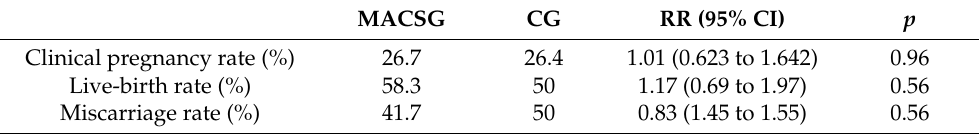
Table 2. Main clinical outcomes. Comparison between clinical outcomes of both semen groups. MACSG CG RR (95% CI) p Clinical pregnancy rate (%) Live-birth rate